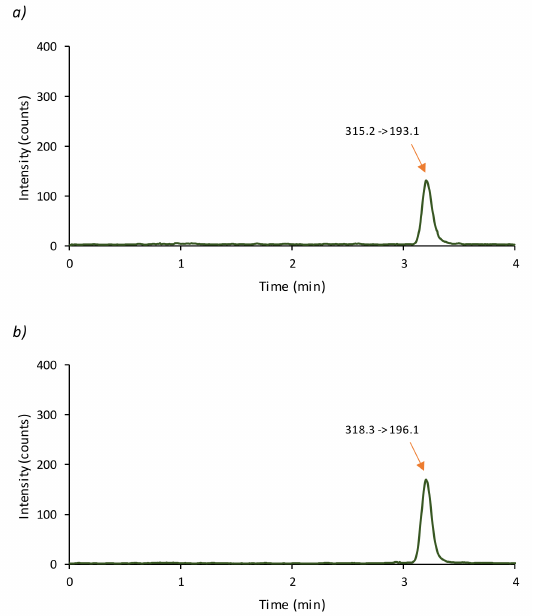
Figure 2. Chromatogram obtained applying the proposed LC-MS/MS method to Cannabis sativa oil raw material (sample G) (( a ) CBD; ( b ) CBD-D3).